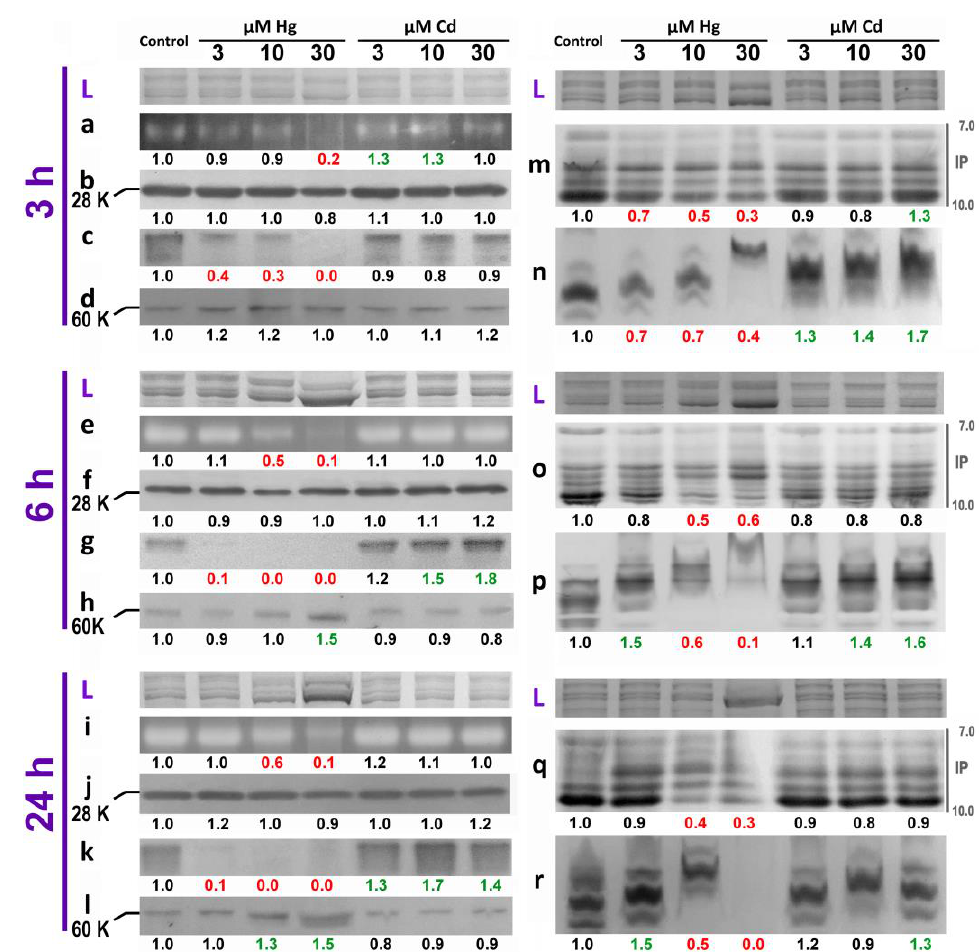
Figure 3. Redox enzymatic activities determined in gel after ND-PAGE, of alfalfa seedlings roots treated with 0, 3, 10, and 30 µ M Hg or Cd for 3, 6, and 24 h. Identification of each band labelled with lower case letters: APX activity ( a , e , i ), α -APX (28 KDa apparent molecular weight) immunodetection ( b , f , j ), GR activity ( c , g , k ), α -GR (60 KDa apparent molecular weight) immunodetection ( d,h , l ), alkaline POX after isoelectric focusing at the immobilised pH (IP) 7.0 to 10.0 range ( m , o , q ), and plasmalemma NADPH-oxidase ( n , p , r ). Band intensity was normalised against Coomassie blue general protein staining after denaturing PAGE, corresponding to L (protein loading) bands. The numbers represent the fold change relative to control samples. Green (up) and red (down) represent fold-changes greater than 30%.